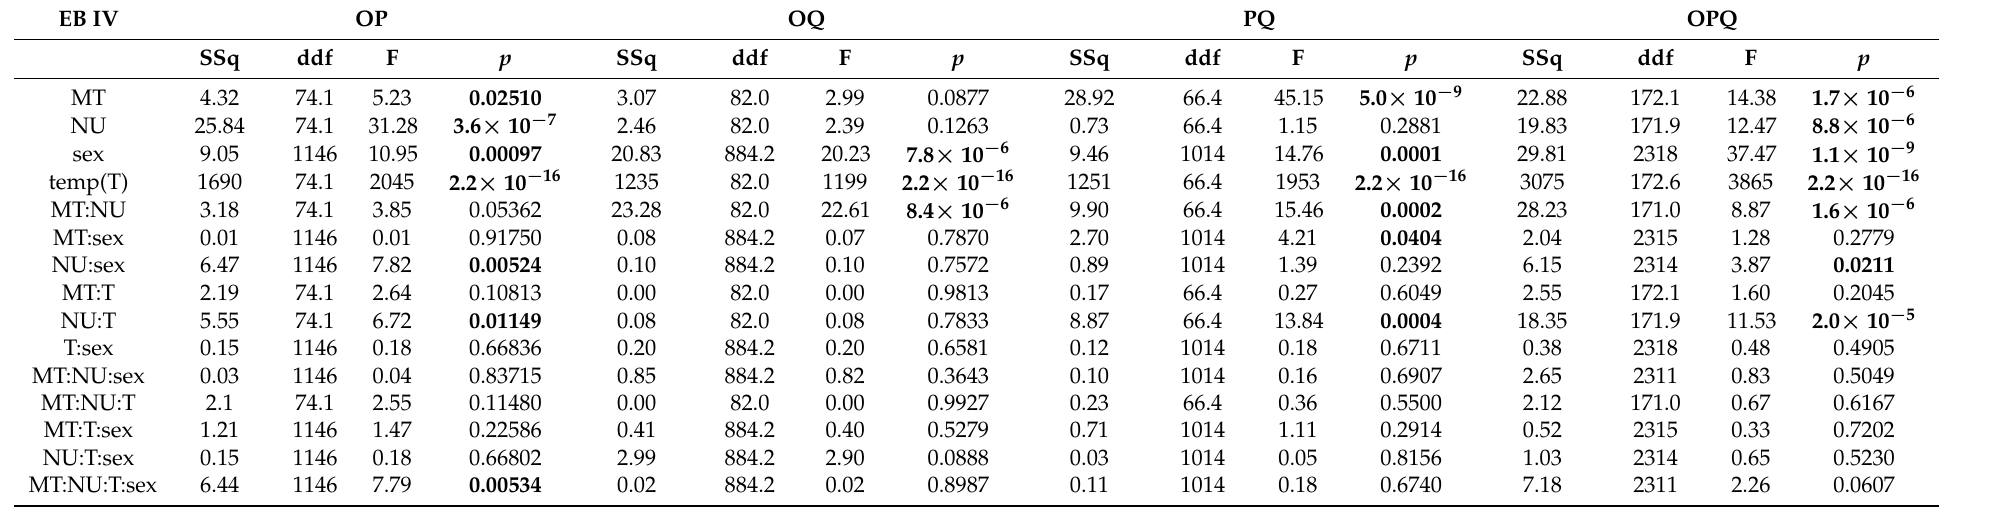
Table 9. The effect of mitochondrial haplotype (MT), nuclear genetic background (NU), sex, temperature (T) and their interactions on developmental time for the three pairwise comparisons from experimental block (EB) IV and the whole EB IV of D. obscura . SSq, sum of squares; ddf, denominator degrees of freedom; p values that are significant at p < 0.05 are given in